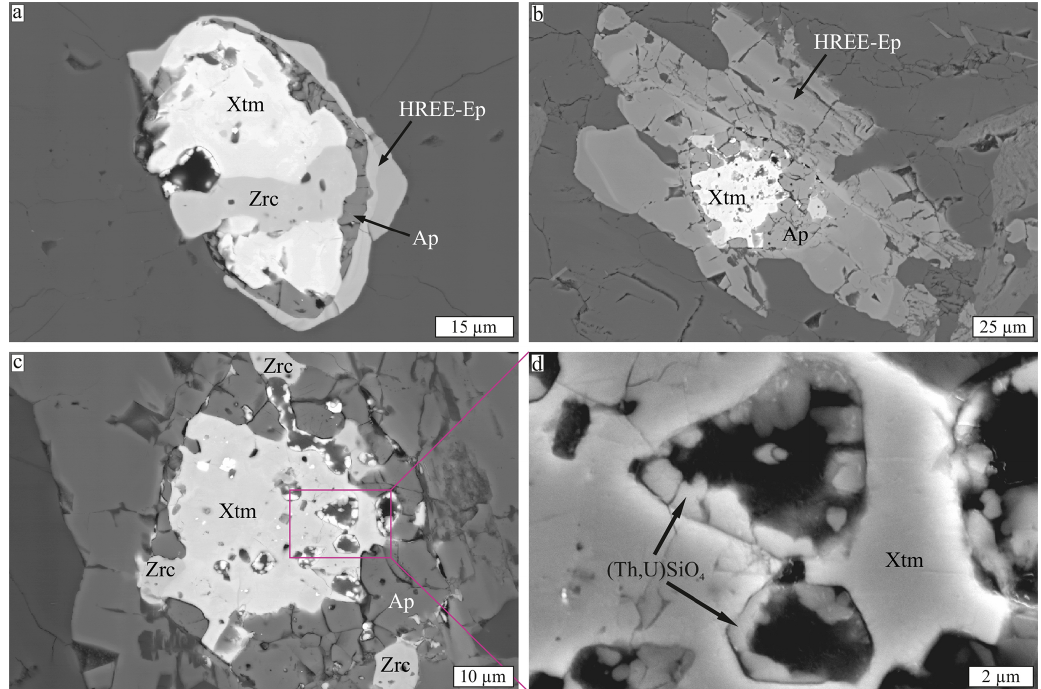
Figure 10. BSE images of coronae around xenotime from sample FH21. (a) Incipient replacement of a xenotime grain accompanied by zircon. (b) Corona on which the compositional measurements were done. (c) Close-up of the xenotime core from (b) , also showing the polygonal fluorapatite grains. (d) Close-up of voids, which are partly filled with thorite at their